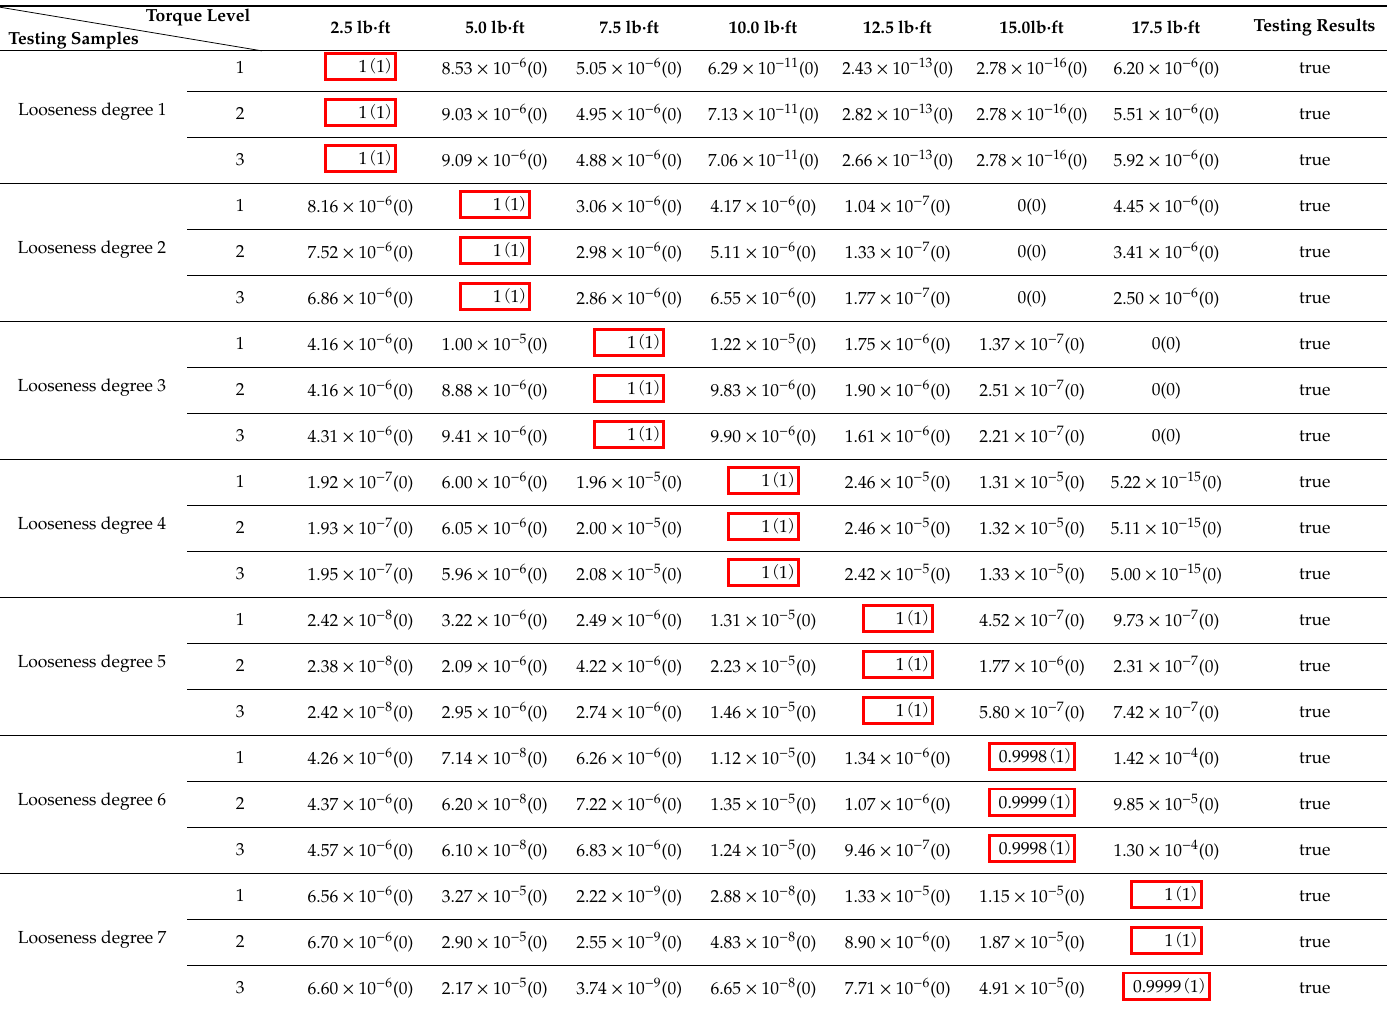
Table 1. The prediction results of trained back propagation neural networks (BPNNs) at different torque levels (the target result of networks in the red boxes). Torque Level